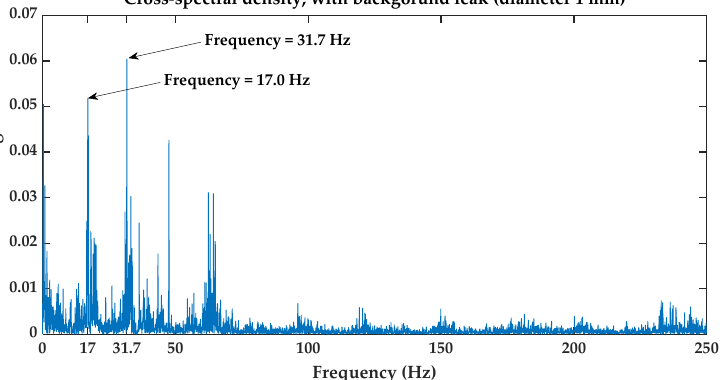
Figure 11. Coherence’s magnitude, with background leak ( 1 mm in diameter) and flow rate 33.7 mL/s . However, the results are shown by the 𝒯 (cid:3032) cross-spectral density (see Figures 12–14) and 𝒯 (cid:3032) coherence (see Figures 15 and 16) show superiority over the above-mentioned procedures. Notice how both the 𝒯 (cid:3032) cross-spectrum and the 𝒯 (cid:3032) coherence highlight the frequency component related to background leakage. This result is due to the fact that these contributions are based on showing a dyadic frequency spectrum that allows ob- taining multi-sensitivity in the frequency spectrum, which allows detection of back- ground leakage of 1 mm in diameter.